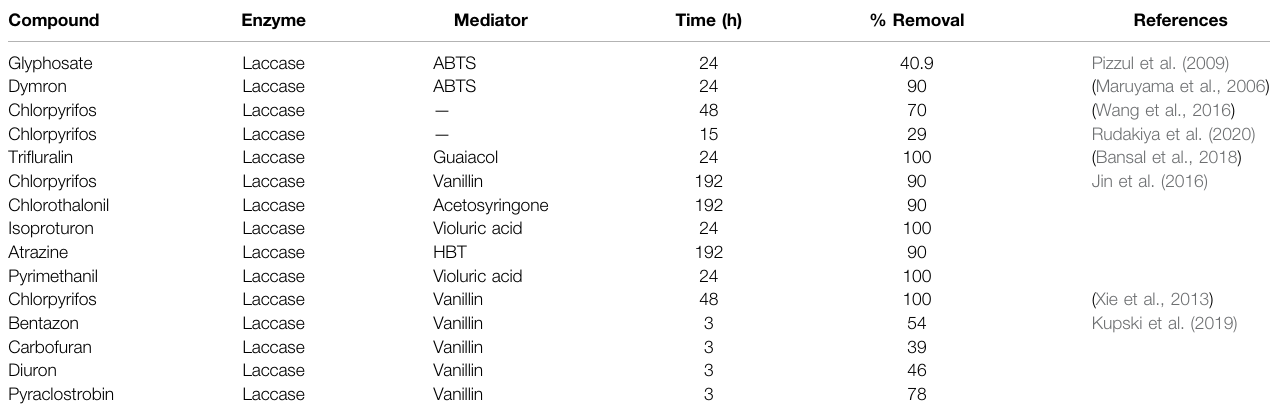
TABLE 3 | Previous fi ndings for removal of pesticides with free laccases.